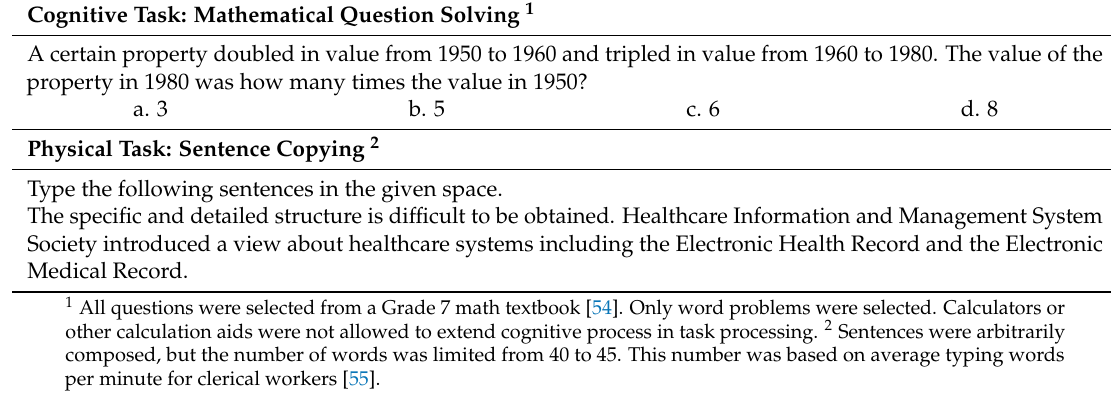
Table 2. Sample questions for cognitive and skill